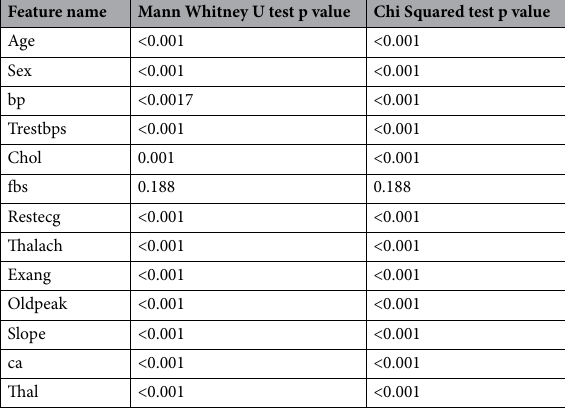
Table 2. Mann Whitney U test and Chi squared test outcomes.